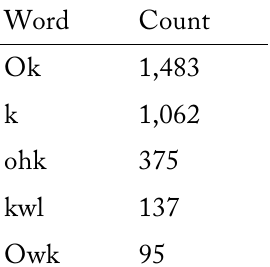
Table 4: Examples of words containing the letter